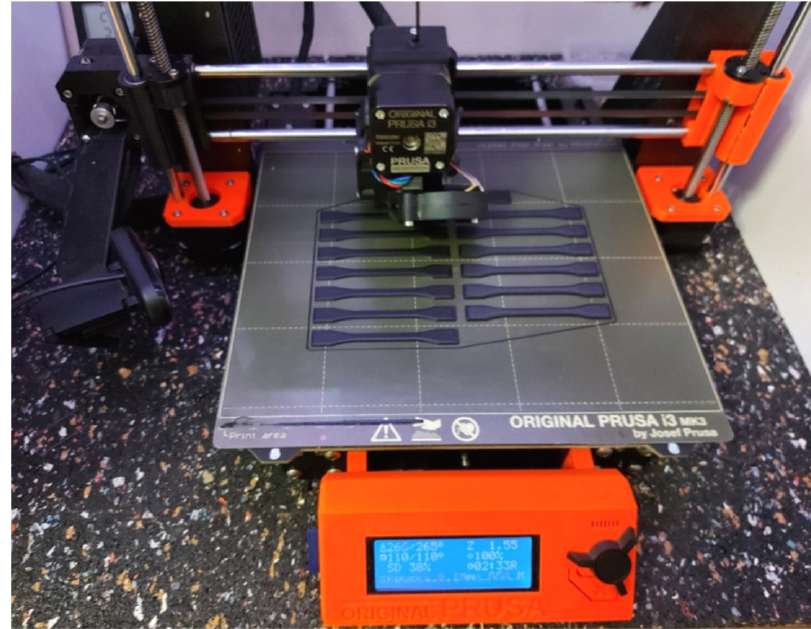
Figure 3. Preparation of samples on a 3D printer.